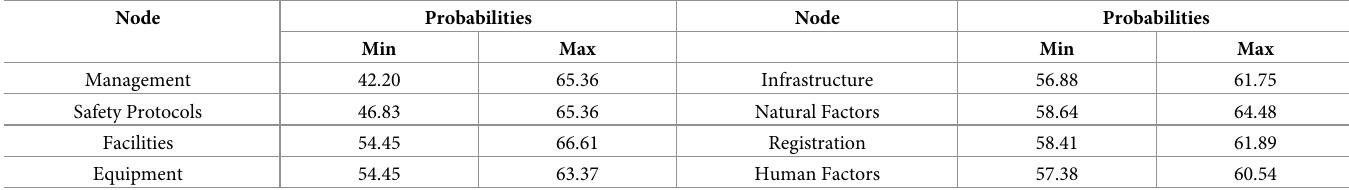
Table 3. Sensitivity analysis for the environment and pollution accident